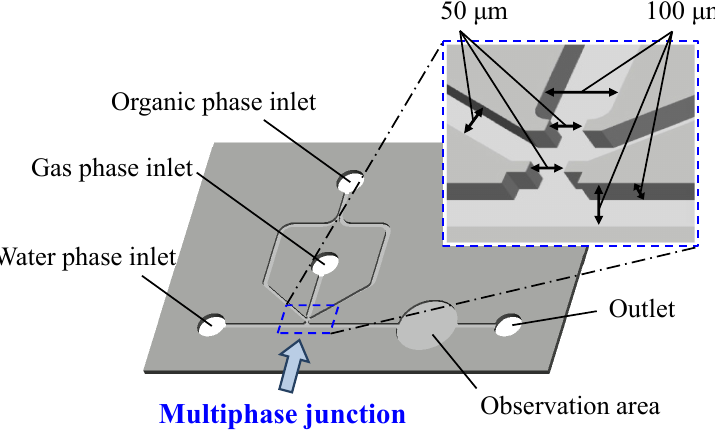
Figure 2. Silicon wafer design for microdroplet generation and, in the inset, detail of the multiphase